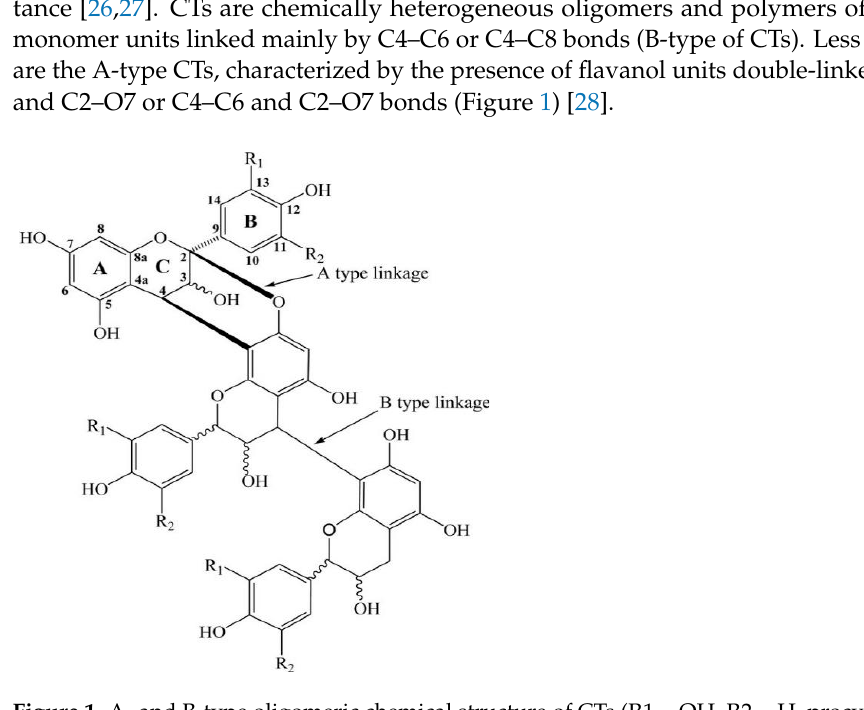
Figure 1. A- and B-type oligomeric chemical structure of CTs (R1 = OH, R2 = H, procyanidin) [28].